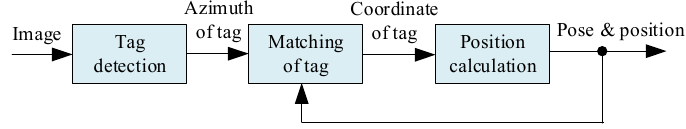
Figure 2. Location algorithm with high accuracy.